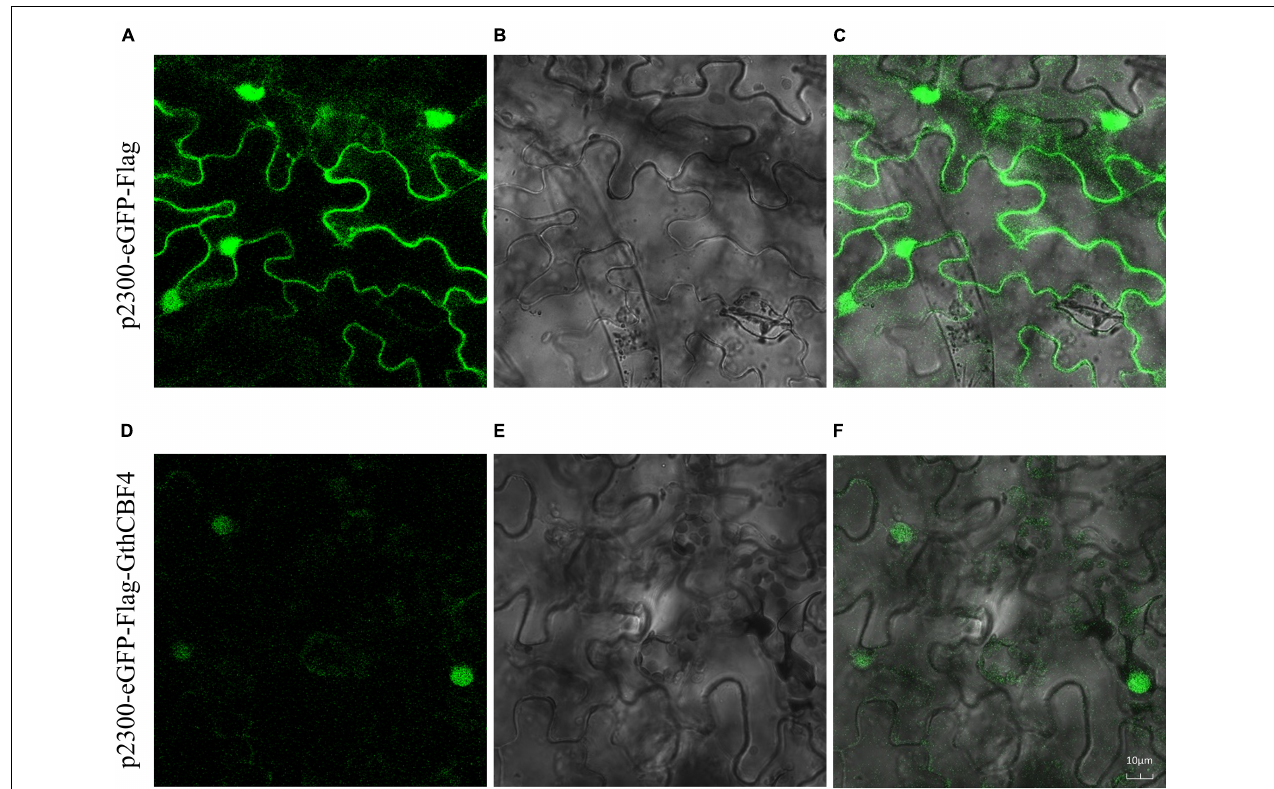
FIGURE 5 | Localization of pCAMBIA2300-eGFP-Flag- GthCBF4 in tobacco leaf. (A–C) Tobacco epidermal cells transformed with pCAMBIA2300-eGFP; (D–F) Onion epidermal cells transformed with pCAMBIA2300-eGFP-Flag- GthCBF4 . (A,D) A light field with the magnification of X400 to display morphology. (B,E) Dark field images for the detection of green fluorescent protein (GFP) fluorescence. (C,F) Superimposed light and dark field